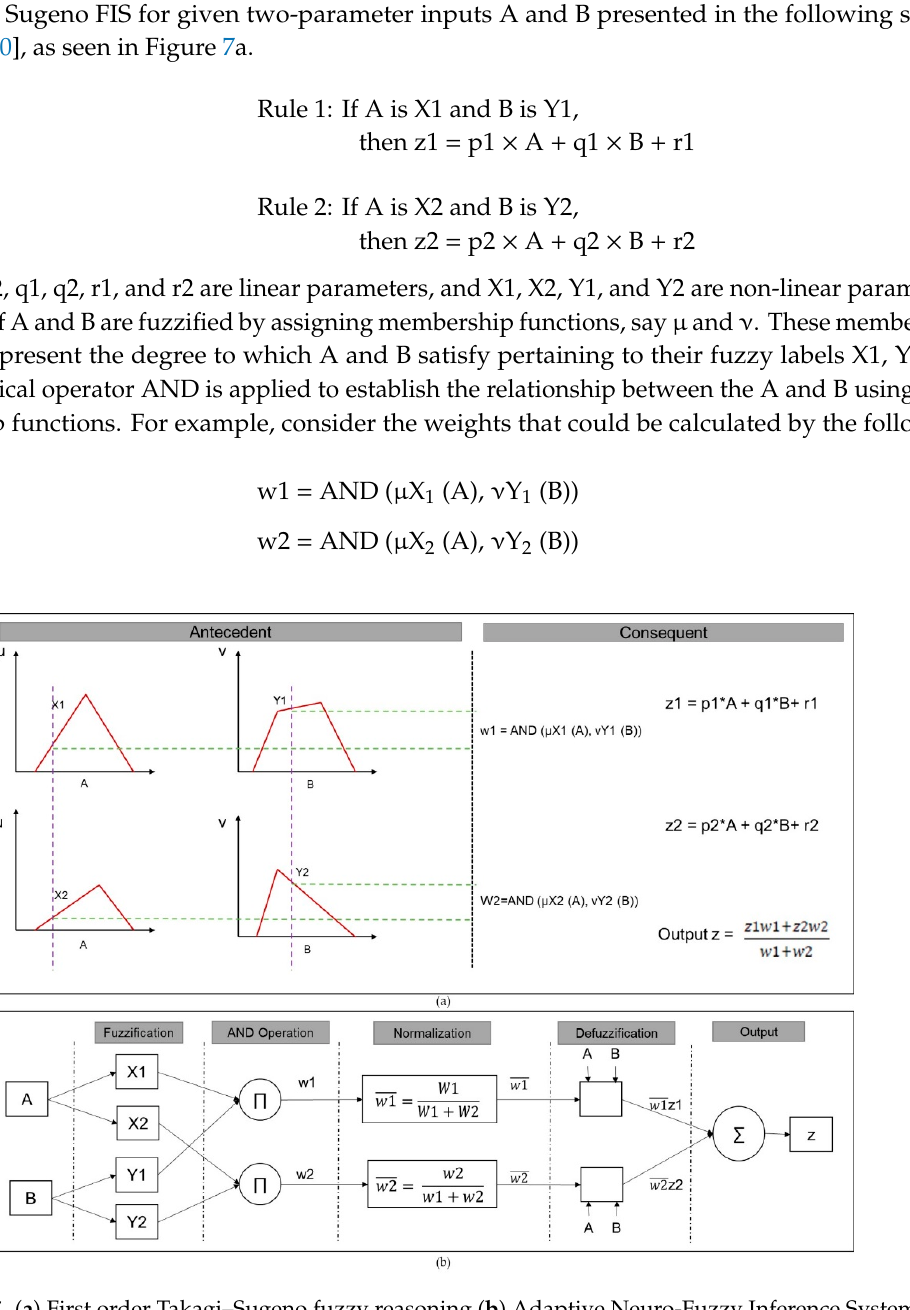
Figure 7. ( a ) First order Takagi–Sugeno fuzzy reasoning ( b ) Adaptive Neuro-Fuzzy Inference System (ANFIS) structure (adapted from [30]).